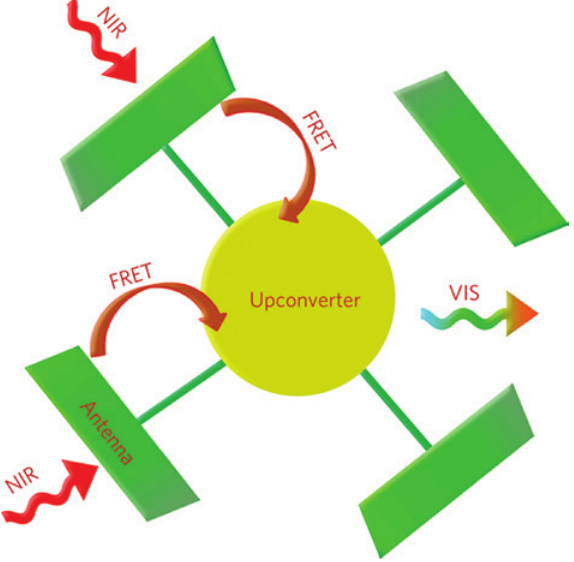
Figure 8: Schematic illustration of a dye-sensitized UCNP. The “antenna” (organic dye) absorbs NIR light and transfers it to the NP core, where upconversion emission